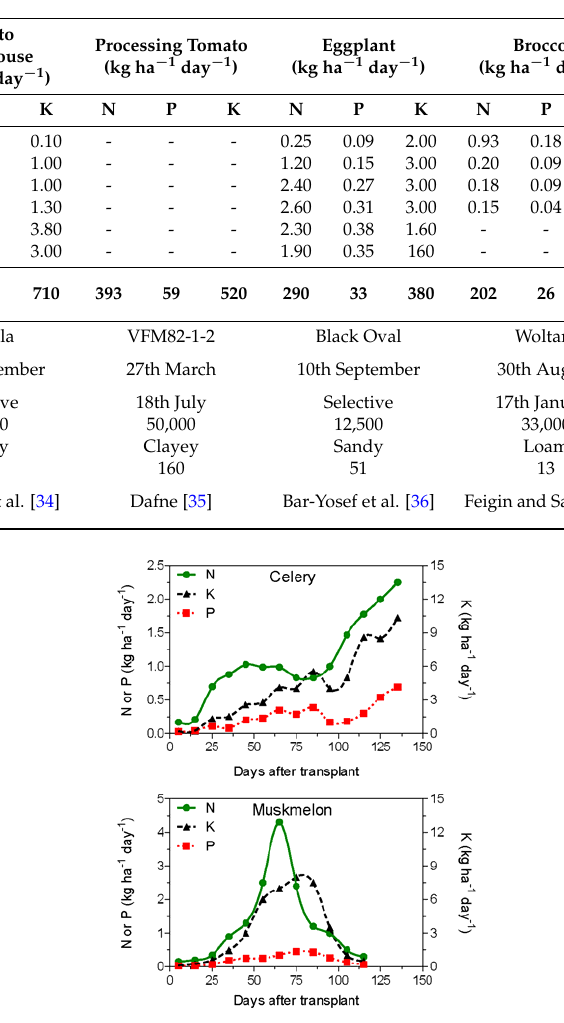
Figure 2. Characteristic nutrient uptake rates of a fertigated leafy vegetable (celery; rearranged from Feigin et al. [39]) and a fruit crop (muskmelon; rearranged from Sagiv et al. [40]).